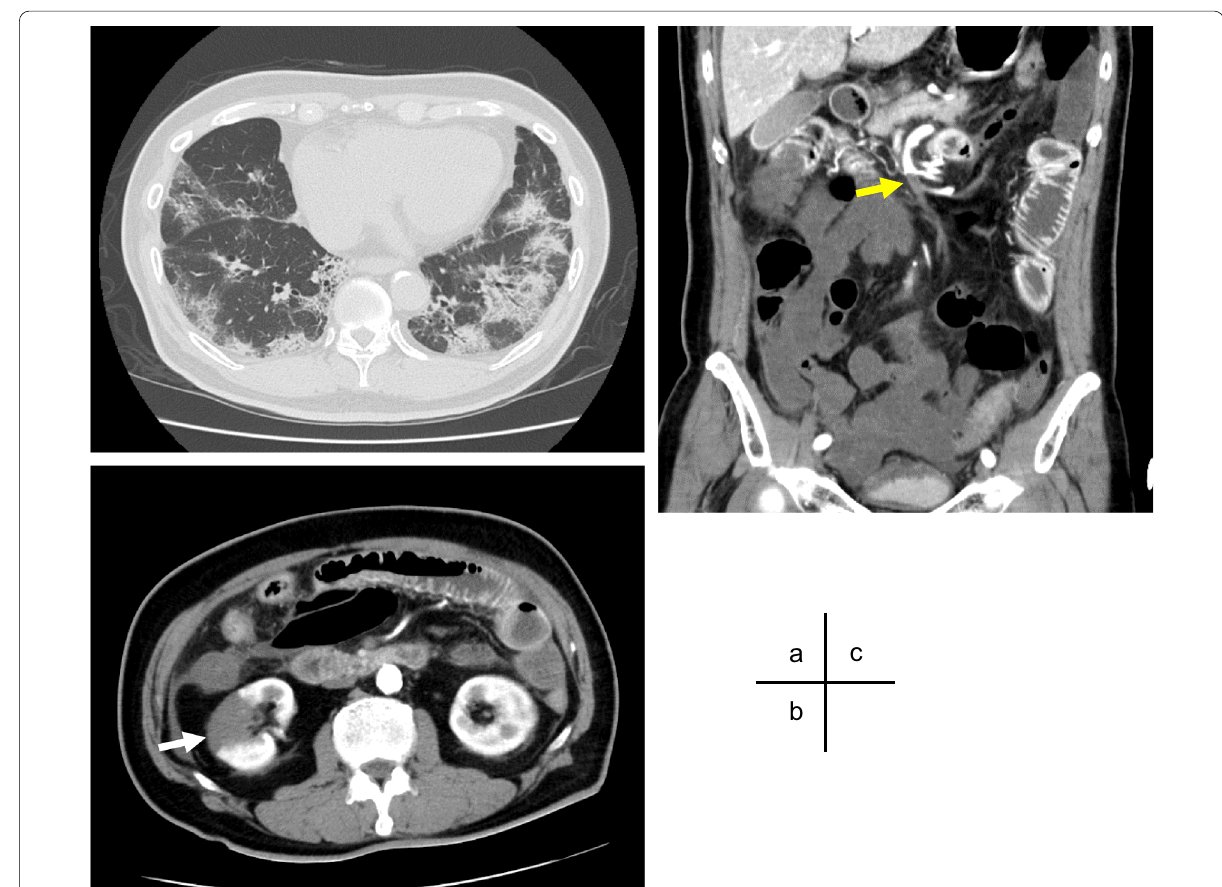
Fig. 1 Contrast computed tomography (CT). Contrast CT revealed ground glass opacification with distribution suggestive of COVID-19 pneumonia ( a ), right renal infarction ( b , white arrow), and superior mesenteric artery occlusion (yellow arrow) with intestinal ischemia suggesting extensive necrosis from the jejunum to the transverse colon ( c